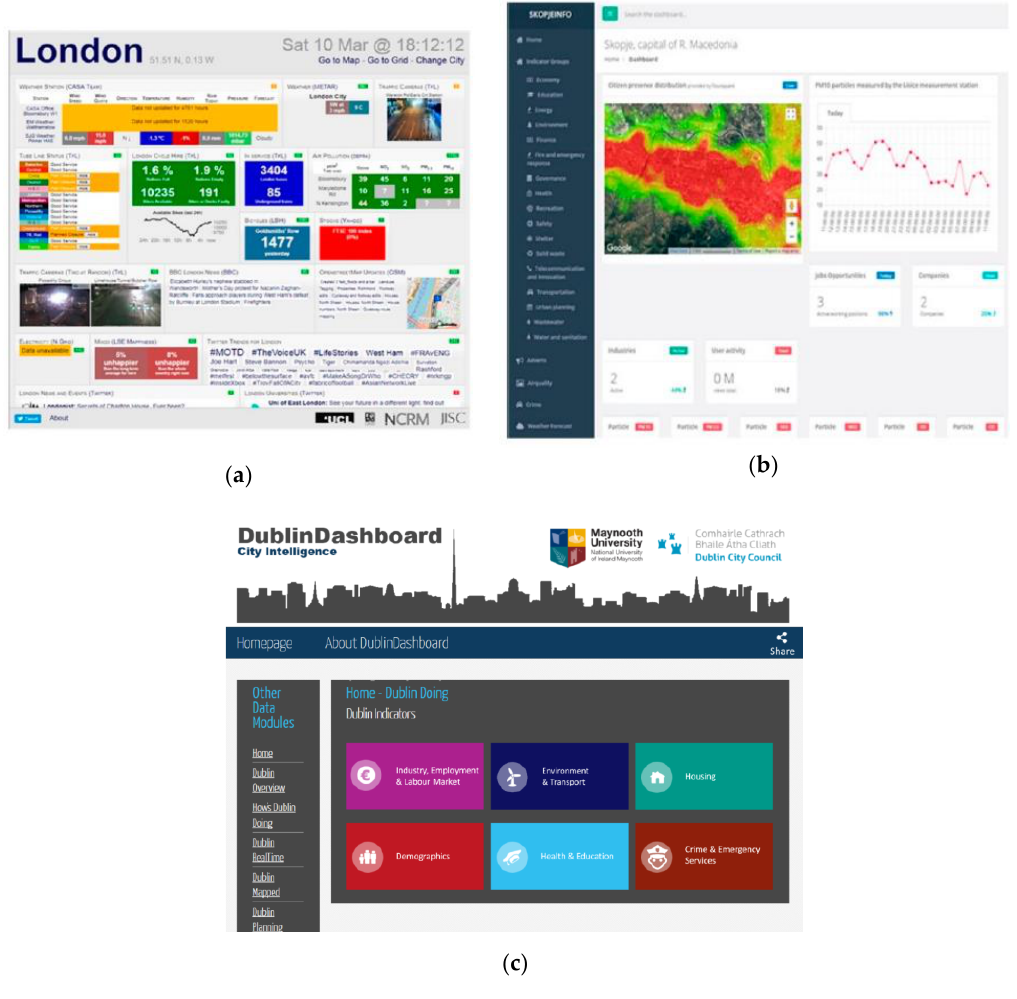
Figure 1. Screenshots of some example dashboards. (a) London CityDashboard, one page with row, (b) Skopje dashboard, drill-down with menu, (c) Dublin dashboard, drill-down with the menu.